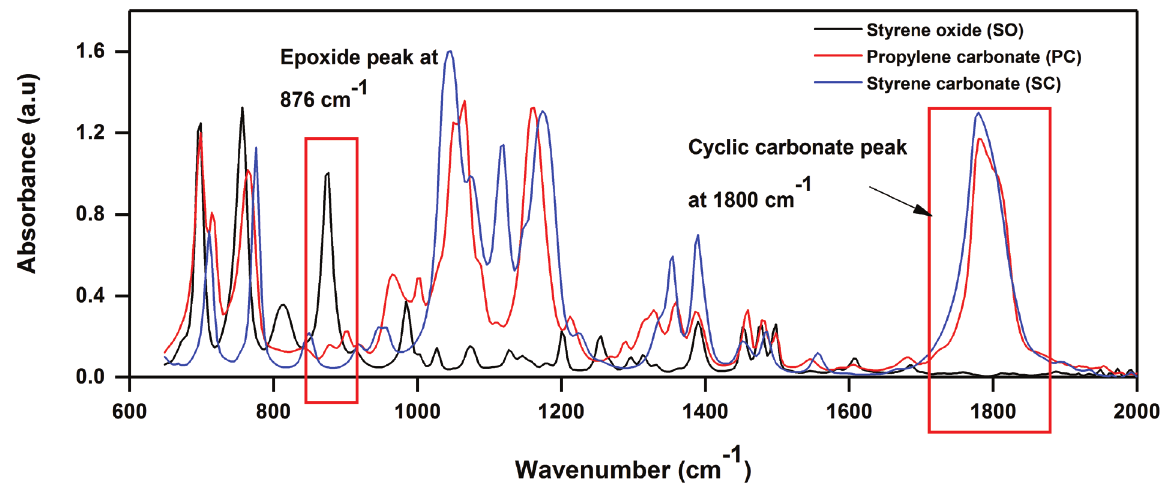
Figure 5: FTIR spectra showing the overlapping of propylene carbonate (PC) and styrene carbonate (SC) peaks at 1800 cm –1 .